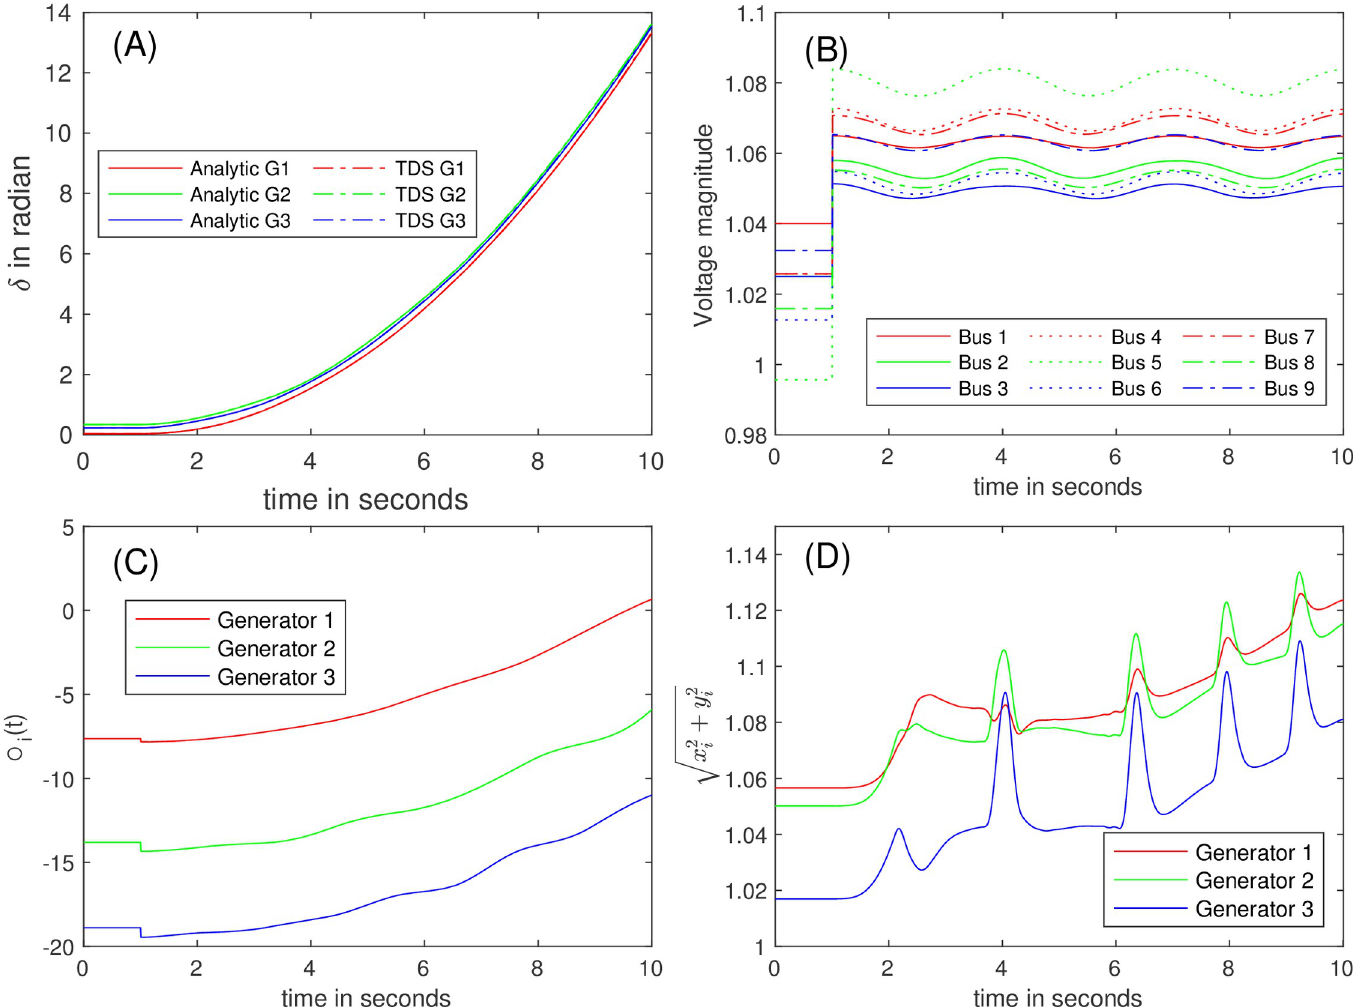
Fig 7. The trajectories of (A) δ , of (B) E , of (C) O arrow in Fig